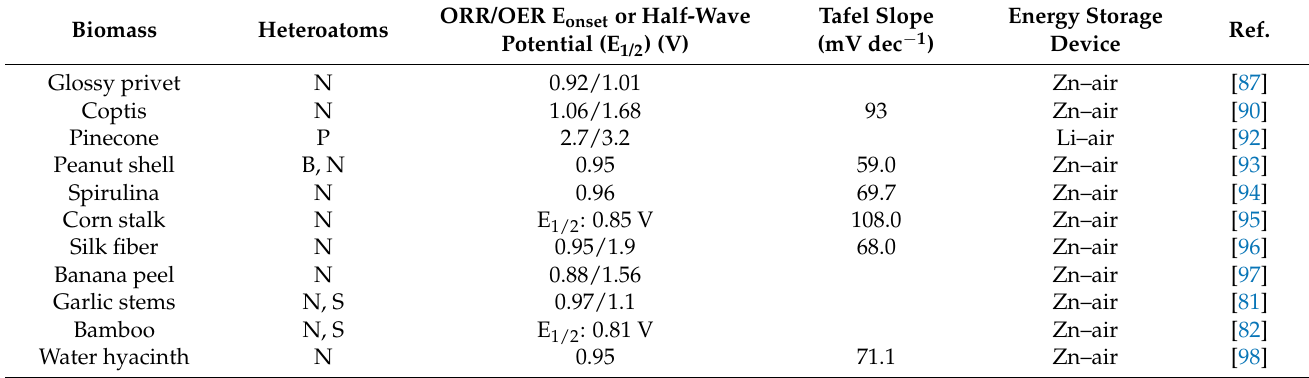
Table 1. Biochars with heteroatoms being electrode for metal–air batteries.